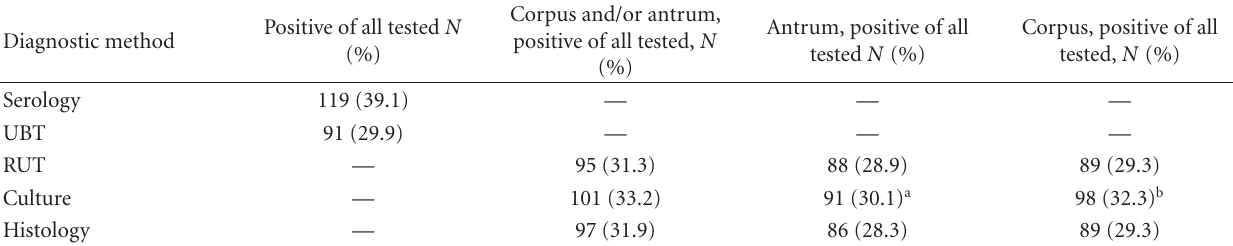
Table 1: Results of di ff erent tests for H. pylori infection in population-based cohort of 304 subjects.